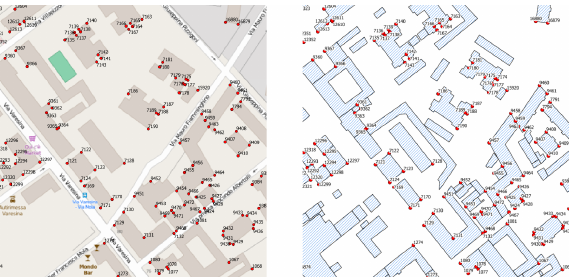
Figure 4. Homologous points automatically detected between the OSM buildings (left) and the REF buildings (right)